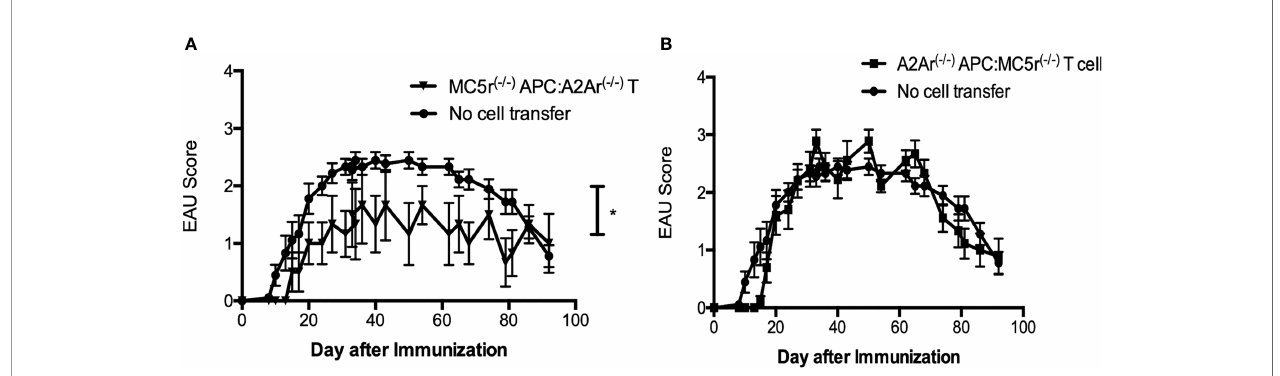
FIGURE 1 | Activation requirements of post-EAU regulatory macrophages and T cells in MC5r -/- and A2Ar -/- mice. APC and T cells from post-EAU MC5r -/- and A2Ar -/- mice were collected. APC and T cells were cultured in vitro with IRBP and adoptively transferred to recipient mice immunized for EAU. The solid line with closed circles are EAU control mice that did not receive an adoptive transfer of spleen cells (no cell transfer, n = 18). Post-EAU MC5r -/- APC were used to activate post-EAU A2Ar -/- T cells and transferred to a recipient mouse and immunized for EAU ( A , solid line with inverted triangles, n = 6). Post-EAU A2Ar -/- APC were used to activate post-EAU MC5r -/- T cells and transferred to a recipient mouse and immunized for EAU ( B , solid line with squares, n = 10). Disease was monitored every 3-4 days from the time of immunization through resolution. Each experiment consisted of 4-5 mice, and each experiment was repeated 2-4 times. Signi fi cant suppression of disease was observed compared to EAU mice that received no cell transfer (*P< 0.05), determined by two-way ANOVA with Bonferroni